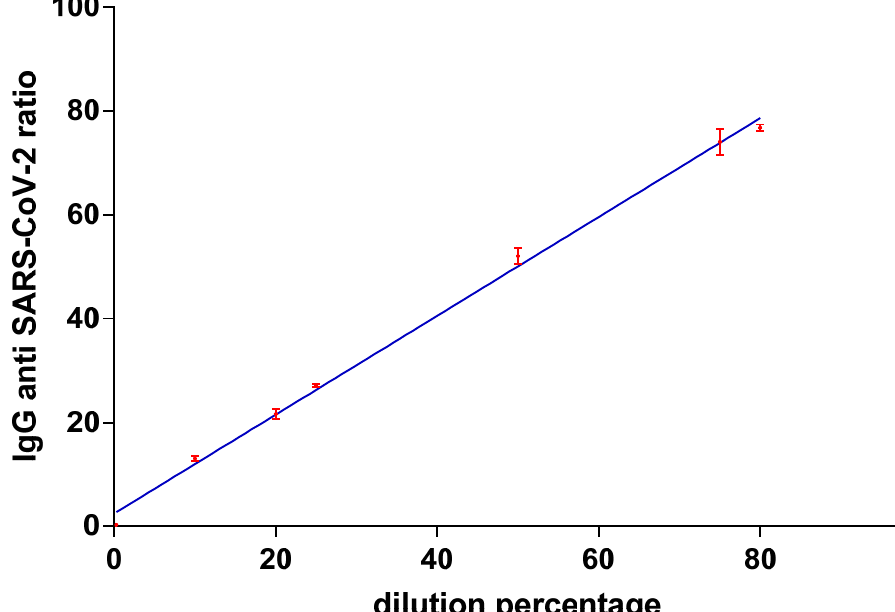
Figure 3. Linear regression between anti-SARS-CoV-2 IgG levels, expressed as a ratio, and the dilution percentage starting from a DBS sample from a subject with three doses of BNT162b2 vaccine and with previous SARS-CoV-2 infection ( n = 3). Linear regression calculated shows R 2 = 0.99, slope of the line equal to 0.95 ( p -value < 0.0001).